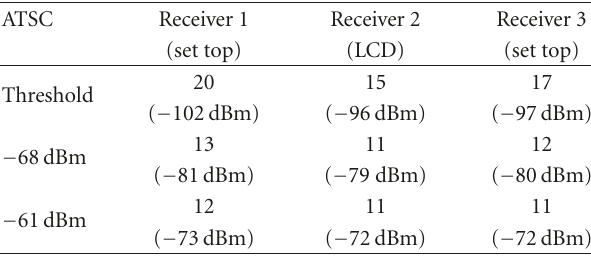
Table 2: Co-channel desired/undesired ratio